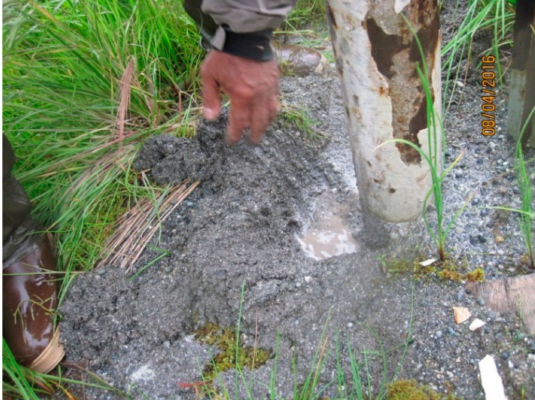
Figure 6. Sample collection at DDH 7382. Material collected at base of drill stem had a gravel texture, but putty-like texture as gravel was scooped